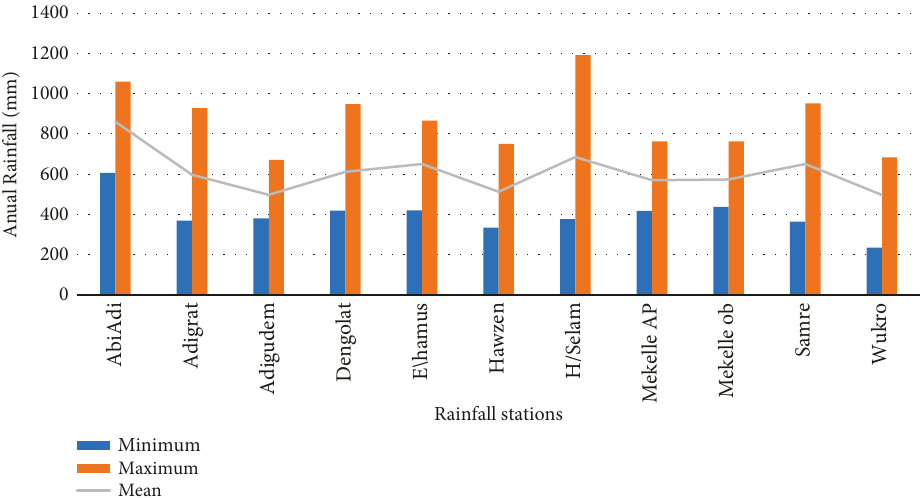
Figure 3: The annual rainfall for the 11 stations of the study